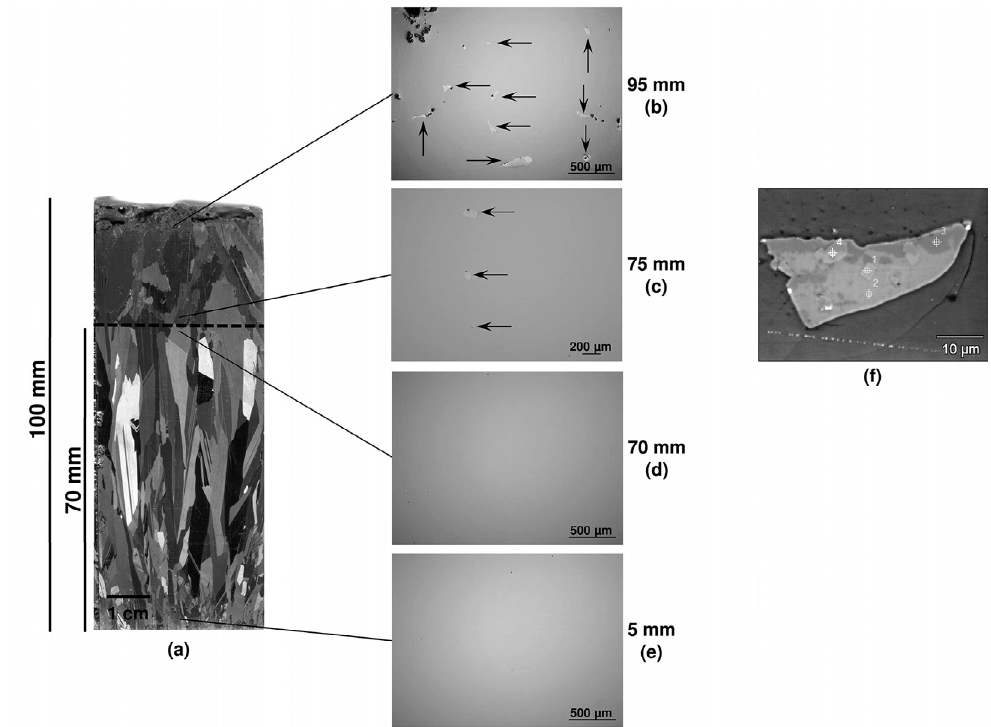
Figure 4. Metallurgical structure of the resulting ingot (central portion): (a) macrograph (etchant: NaOH solution at 90 ºC) and (b,c,d,e) micrographs of the longitudinal section, with arrows pointing to intermetallic particles (no etching, optical microscopy), from different positions relative to the ingot base (indicated on the right). Details of an intermetallic found in (c) are given in (f), showing four spots where EDS microanalyses were carried out (scanning electron microscopy with backscattered electron).